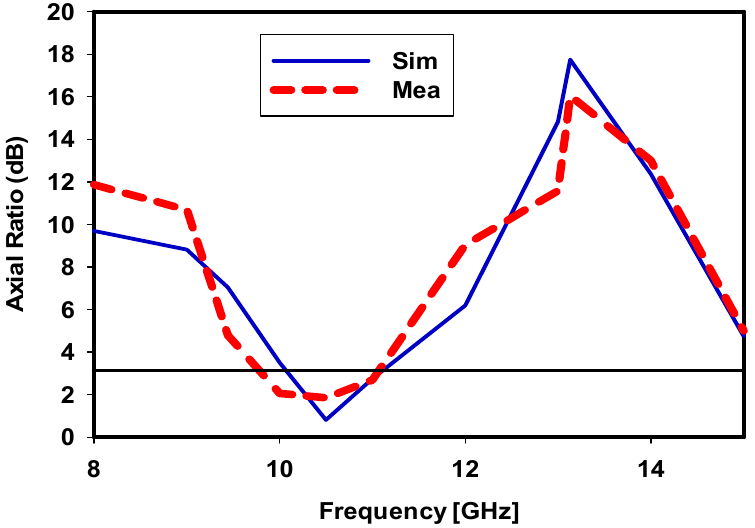
Figure 11. Simulated and measured axial ratios of the design. The proposed design has a good, measured gain, efficiency and radiation pattern. All the measured values are close to the simulated values. The measured peak gain of the design is shown in Figure 12. The measured peak gain of the design is 6.5 dBic, i.e. is less than the simulated value. The measured gain of the design over the axial ratio bandwidth is between 6 to 6.5 dBic. The minor deviation in the measured values is due to imperfect fabrication of the prototype. Figure 13 illustrate the simulated and measured radiation efficiencies of the design. Their values over the entire axial ratio bandwidth are more than 96%. Figure 14 depicts the simulated and measured RH (Right Hand) CP and LH (Left Hand) CP far field patterns at 10.5 GHz central frequency of the AR. The electric fields distribution on the DR top surface show that the design is dominantly RHCP by 37 dB in the main direction of the radiation. The direction of radiation at 10.5 GHz is boresight and focused towards 15 ◦ . The radiation pattern of the design in terms of E-field and H-field at 9.44 GHz and 13.13 GHz is depicted in Figures 15 and 16, respectively. The radiation